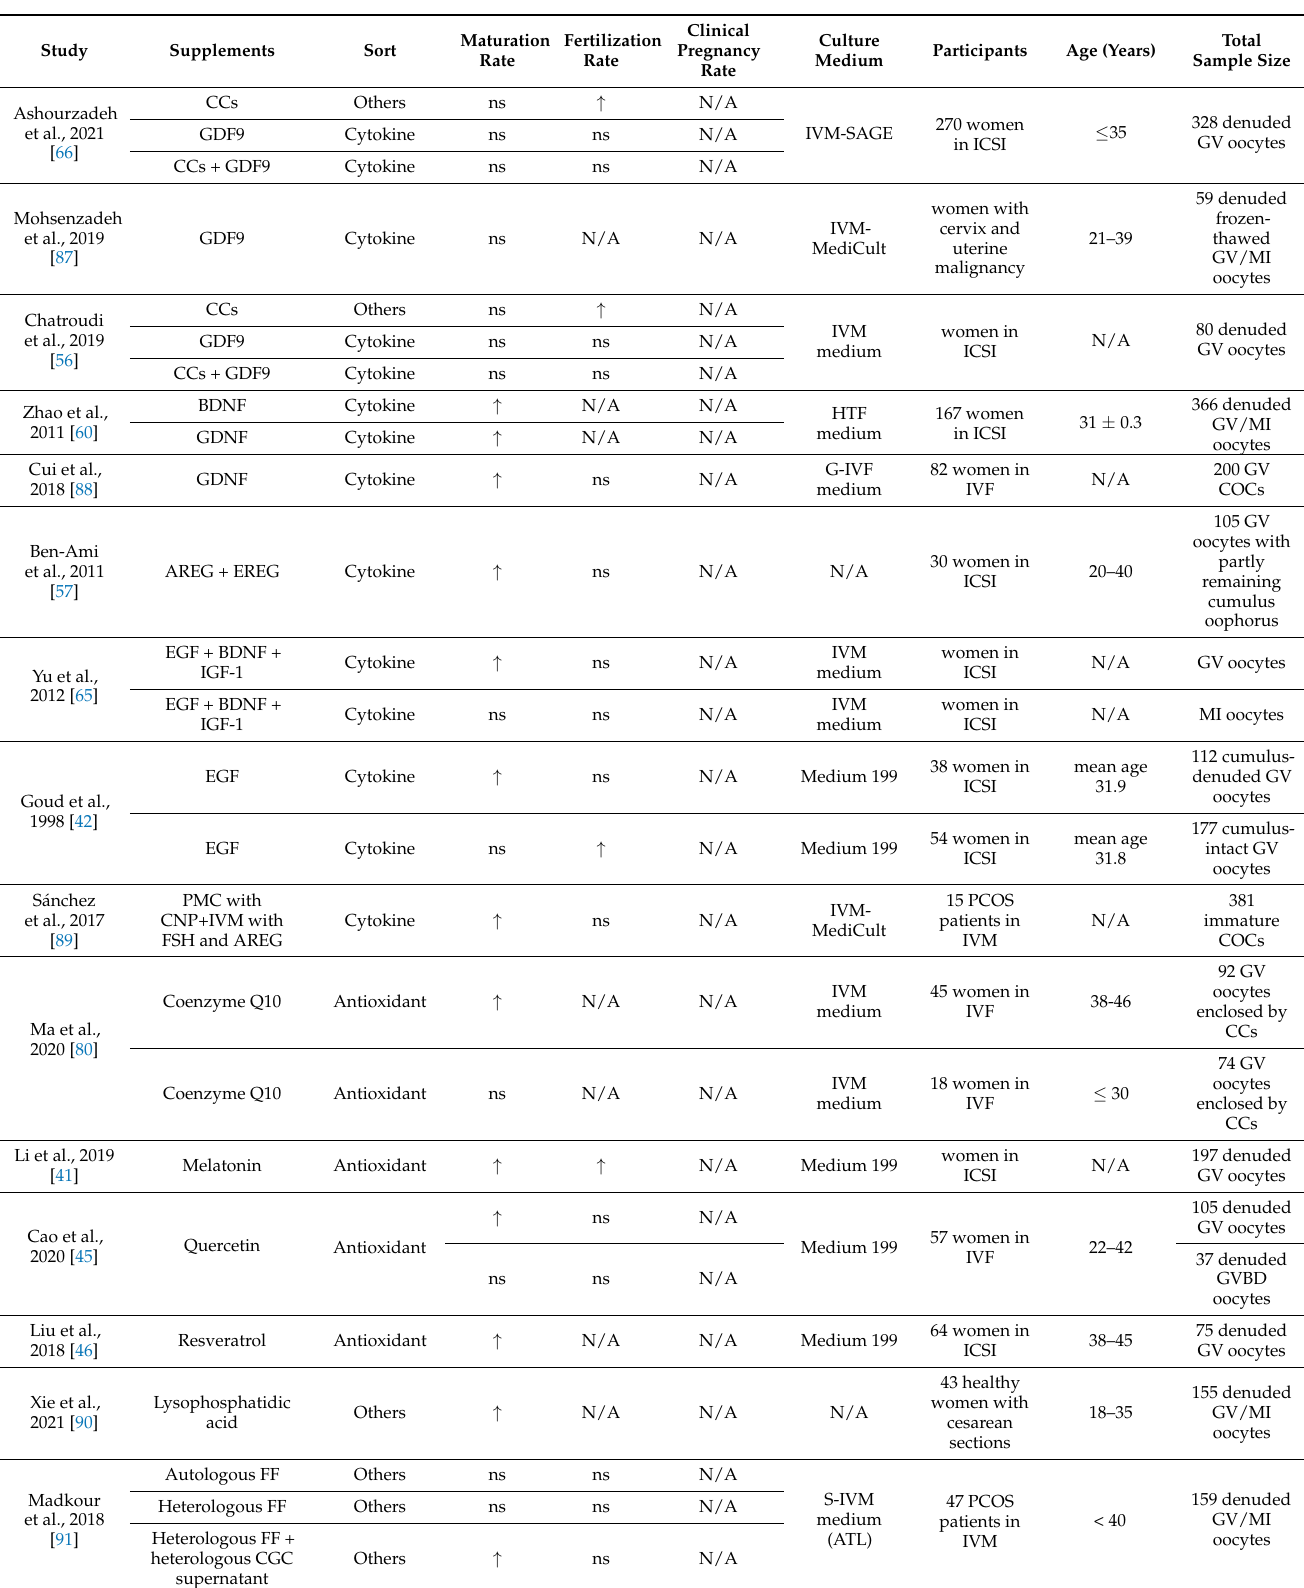
Table 3. Influence of medium supplements on human oocyte